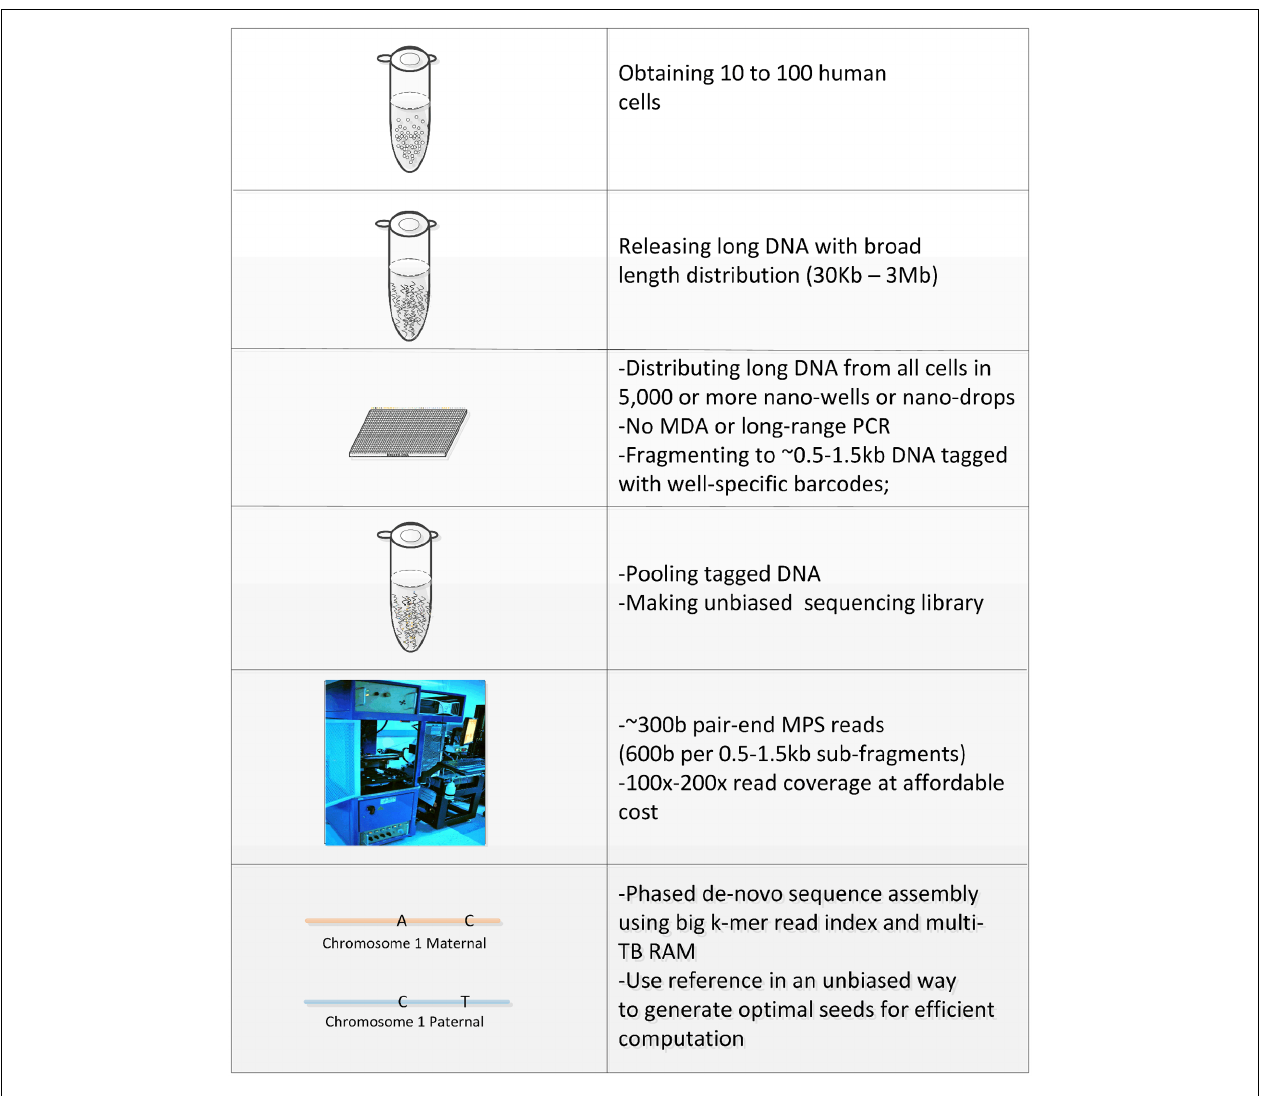
compartments are pooled into a single tube and advanced pair-end MPS using 300 base reads is performed, including reading 10 bases or